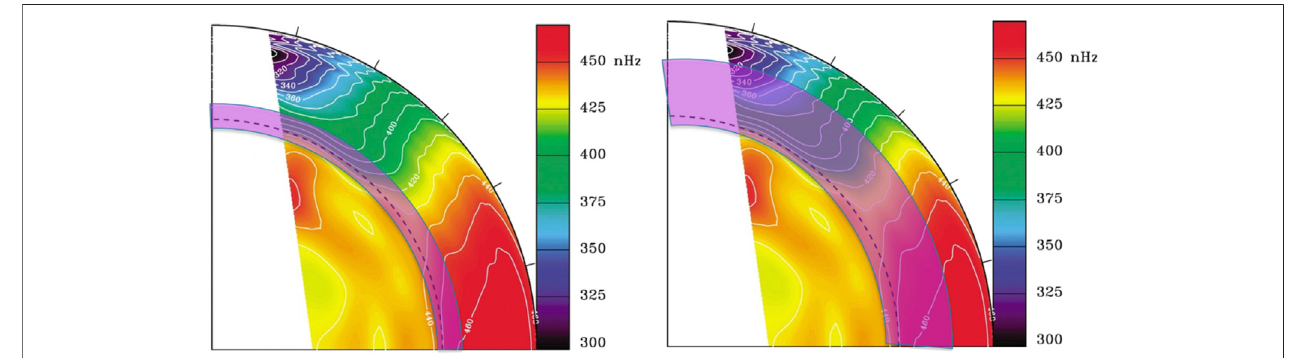
FIGURE 2 | Schematically displayed, in semi-transparent purple-shades superimposed on the helioseismicly-derived solar internal rotation pro fi les ( fi gure 3 of Thompsonet al.,2003),twoextreme cases ofplausible thickness ofthesphericalshellinwhichshallow-watermodelscanbeapplied: (left) verythintachocline plasma- fl uid shell and (right) much thicker shell extending up to the middle of the convection zone.